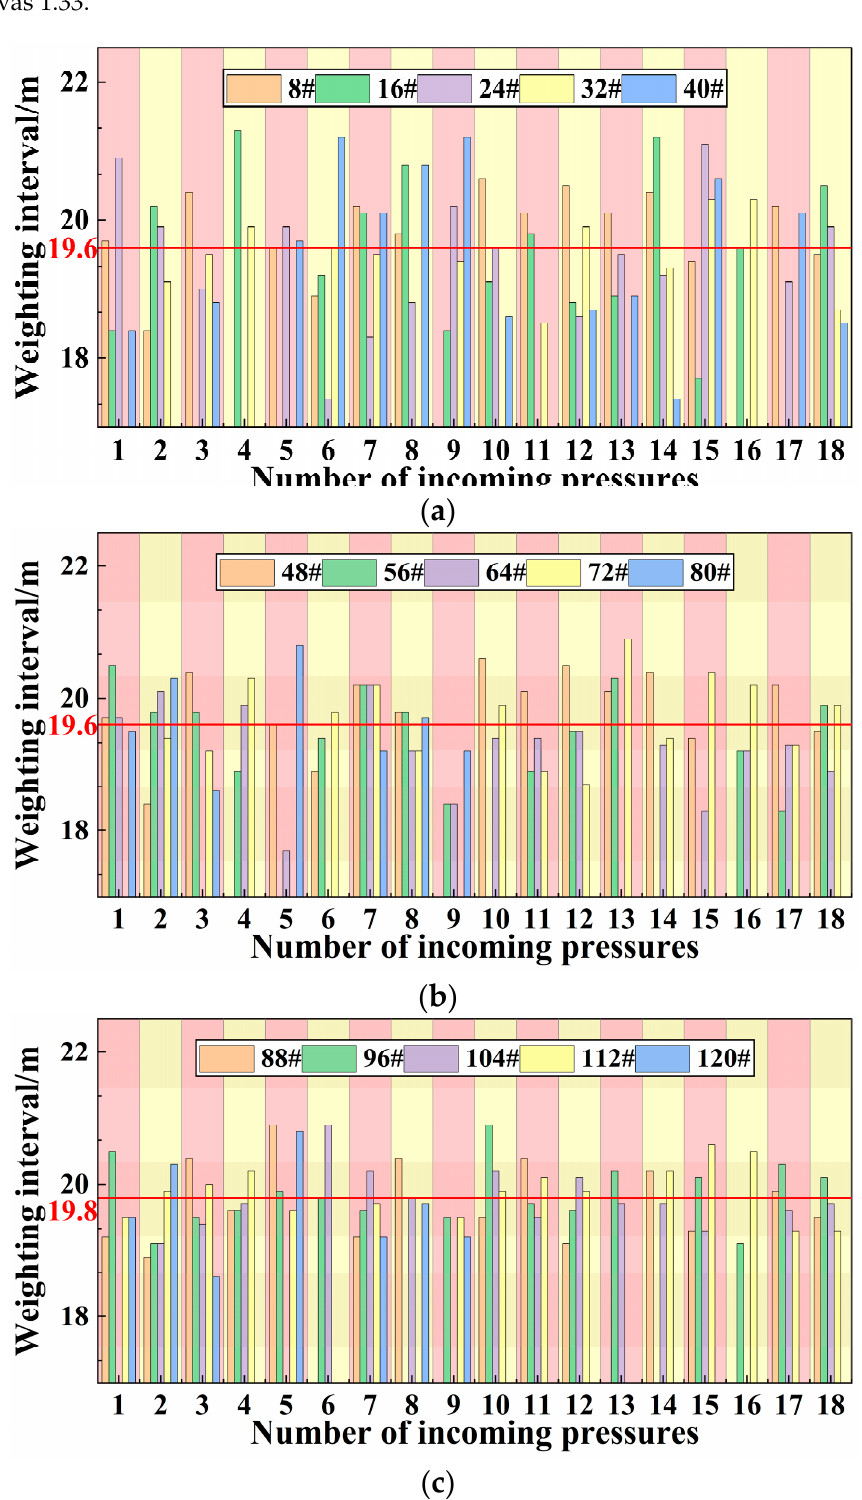
Figure 14. Roof cycle to pressure step statistics: ( a ) is the upper working face periodic pressure step; ( b ) is the middle working face periodic pressure step; and ( c ) is the lower working face periodic pressure step.